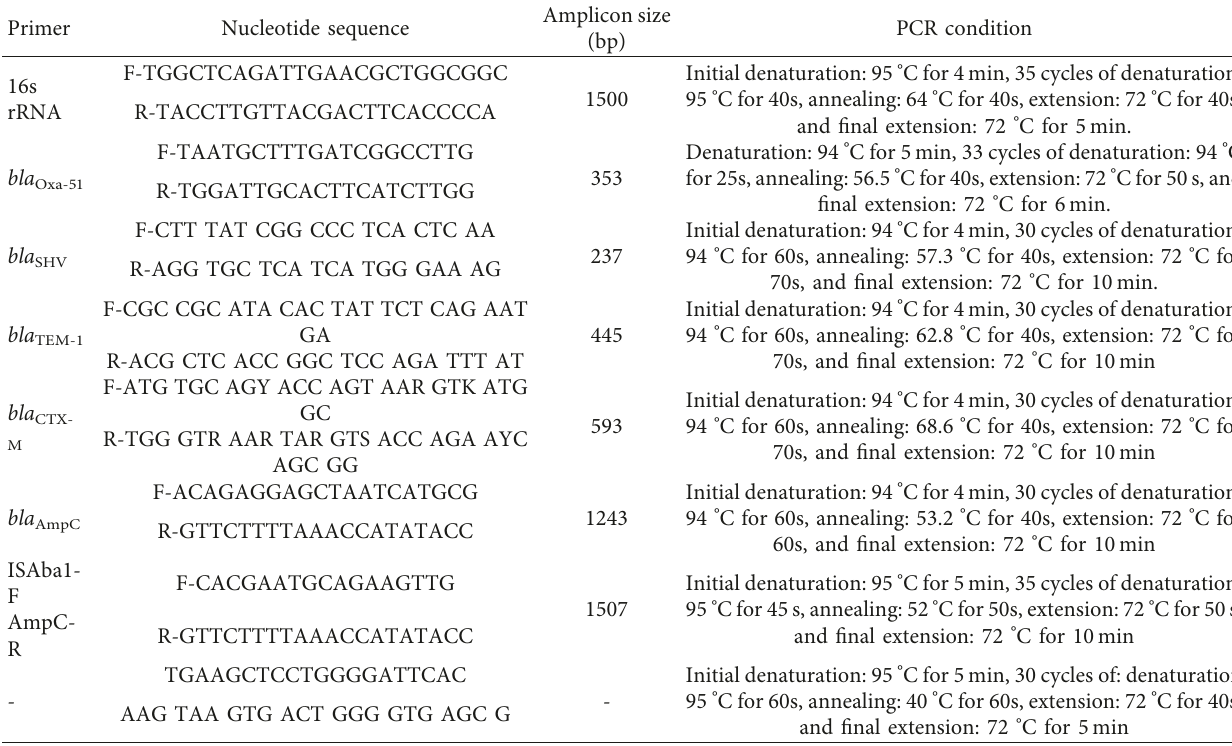
Table 1: Primers and PCR settings used in this